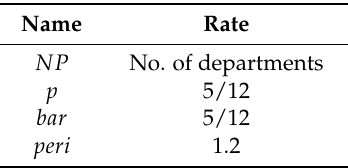
Table 2. Parameters used in MBO.